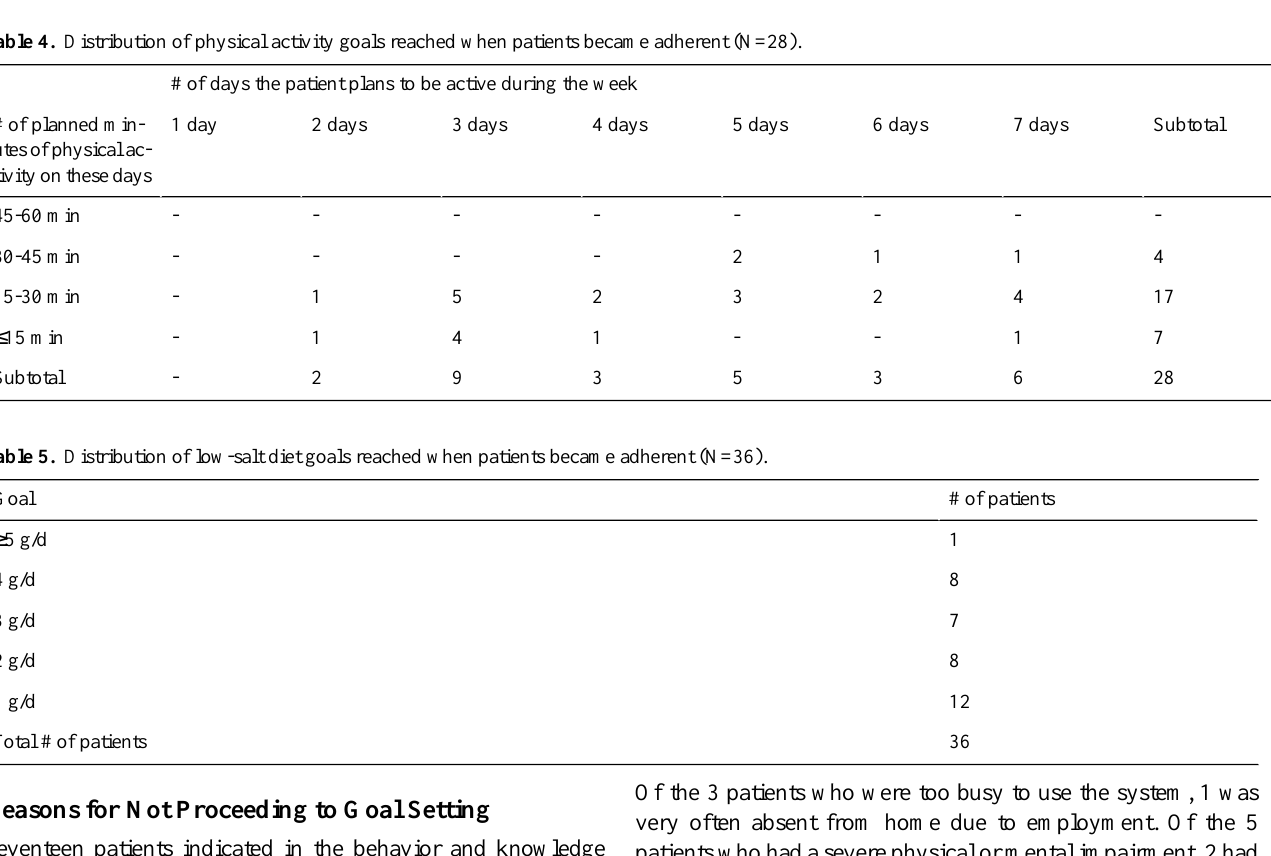
Table 4. Distribution of physical activity goals reached when patients became adherent (N=28). # of days the patient plans to be active during the week